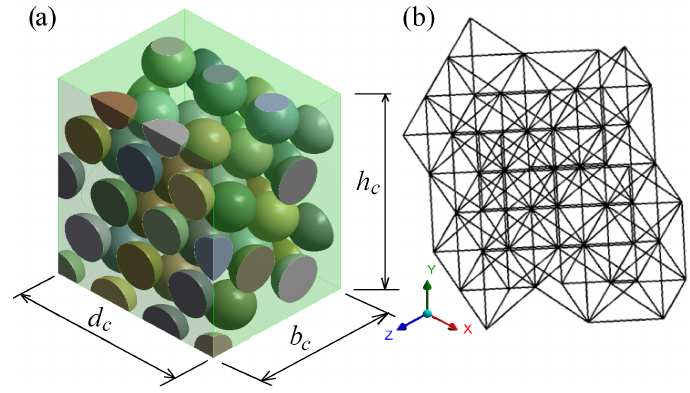
Figure 6. 3D model of the cube particulate composite ( a ) and its spring model ( b ).